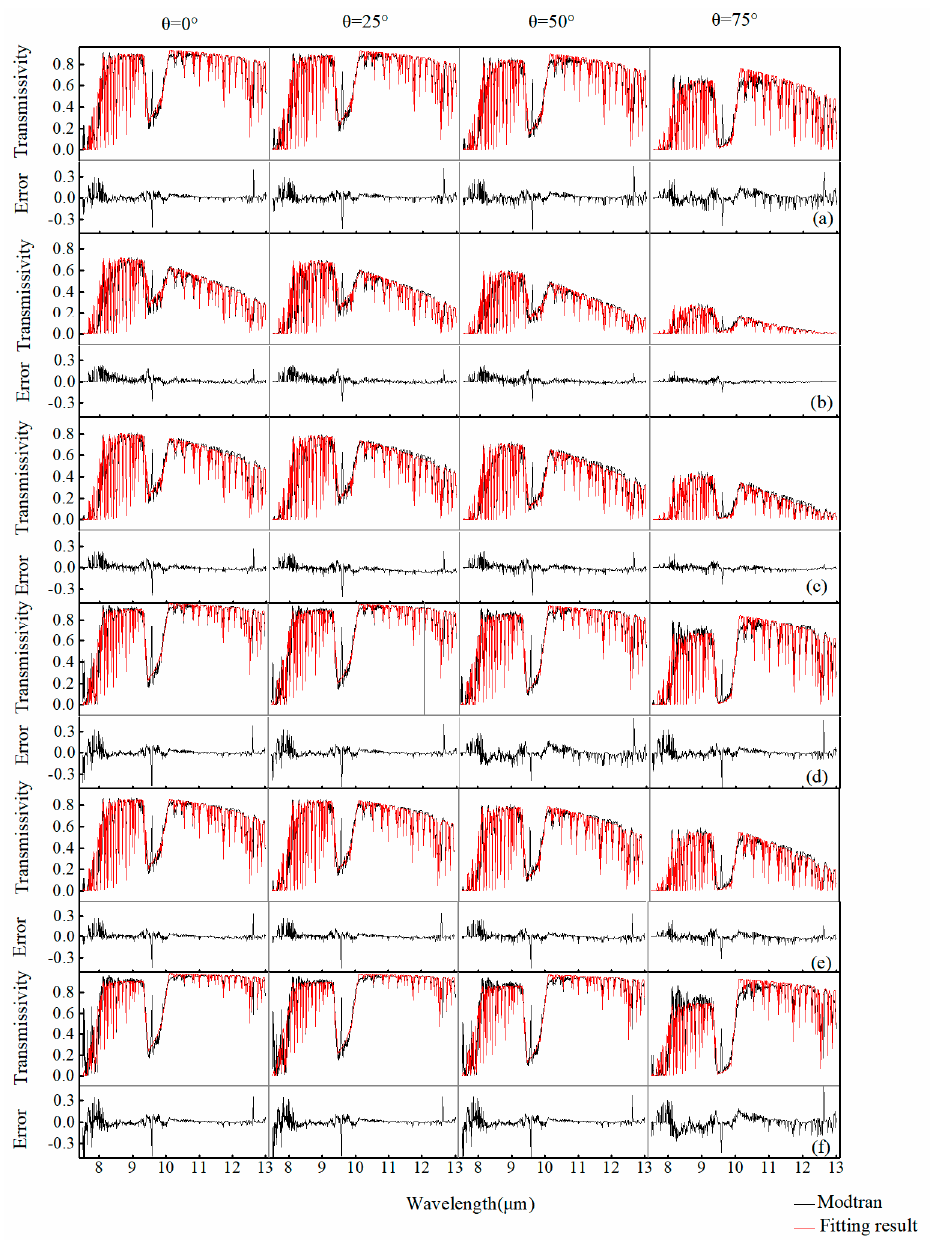
Figure 7. Atmospheric transmittance results, with adjustment for non-water vapor constituents, compared with Modtran results (( a ) 1976 U.S. Standard, ( b ) Tropical, ( c ) Mid-Latitude Summer, ( d ) Mid-Latitude Winter, ( e ) Sub-Arctic Summer, ( f ) Sub-Arctic Winter).